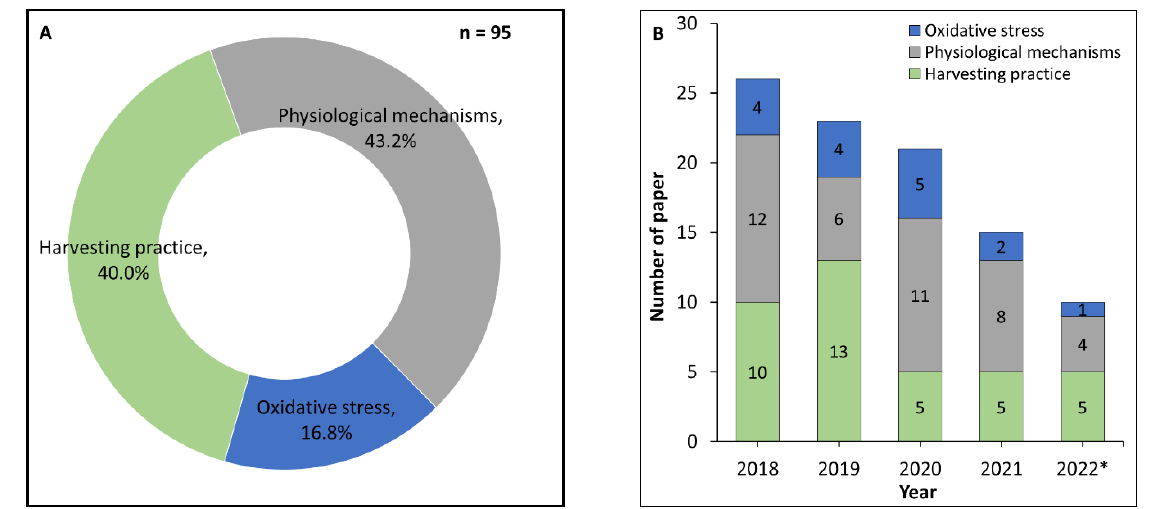
Figure 2. The proportion of literature by sub-topic (A) and number of literature by year (B) used in the bibliographic analysis